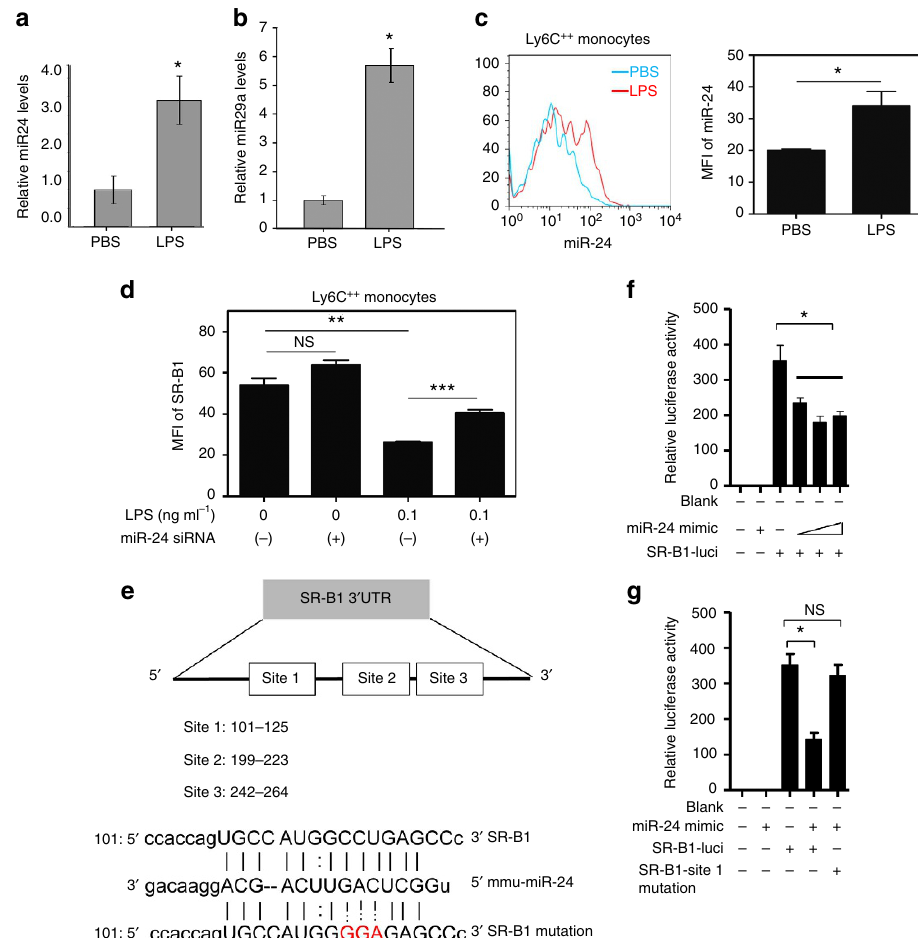
Figure 4 | Suppression of SR-B1 in inflammatory monocytes by super-low-dose LPS is dependent on miR-24 induction. ( a , b ) ApoE (cid:2) / (cid:2) mice were pre-conditioned with PBS or super-low-dose LPS for 4 weeks together with HFD, followed by HFD feeding only for an additional 4 weeks. Total miRs isolated from splenocytes were used for real-time reversre transcriptase–PCR analyses for the relative levels of miR-24 ( a ) and miR-29 ( b ). ( c ) BMMs from C57 BL/6 mice were cultured with M-CSF (10ngml (cid:2) 1 ) in the presence super-low-dose LPS (0.1ngml (cid:2) 1 ) for 3 days and fresh LPS was added to the cell cultures every 2 days. Fluorescent RNA probe for miR-24-3p was added to the cell cultures 16h before harvesting. The expression levels of miR-24-3p within CD11b þ Ly6C þ þ monocytes were examined by flow cytometry. ( d ) BMMs from C57 BL/6 mice were cultured with M-CSF (10ngml (cid:2) 1 ) in the presence super-low-dose LPS (0.1ngml (cid:2) 1 ) and miR-24 antagomir was added to indicated cultures. Fresh LPS and antagomir was added to the cell cultures every 2 days. On day 5, cells were harvested and expression levels of SR-B1 within CD11b þ Ly6C þ þ monocytes were analysed by flow cytometry. ( e ) A schematic illustration of the SR-B1 3 0 -UTR and potential miR-24-binding sites. ( f , g ) Luciferase activity assays in 293Tcells transfected with either WT or mutant SR-B1 3 0 -UTR luciferase reporter plasmids in the presence of miR-24 mimic or scrambles. Quantified data are shown from cells with indicated treatment ( n ¼ 3) and results are representative of three experiments. Error bars show means ± s.e.m.; NS, not significant; * P o 0.05, ** P o 0.01 and *** P o 0.001; ( a , b , c ) Student’s t -test; ( d , f , g ) one-way analysis of